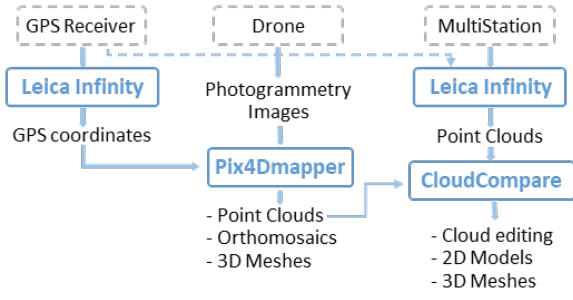
Figure 4. Processing